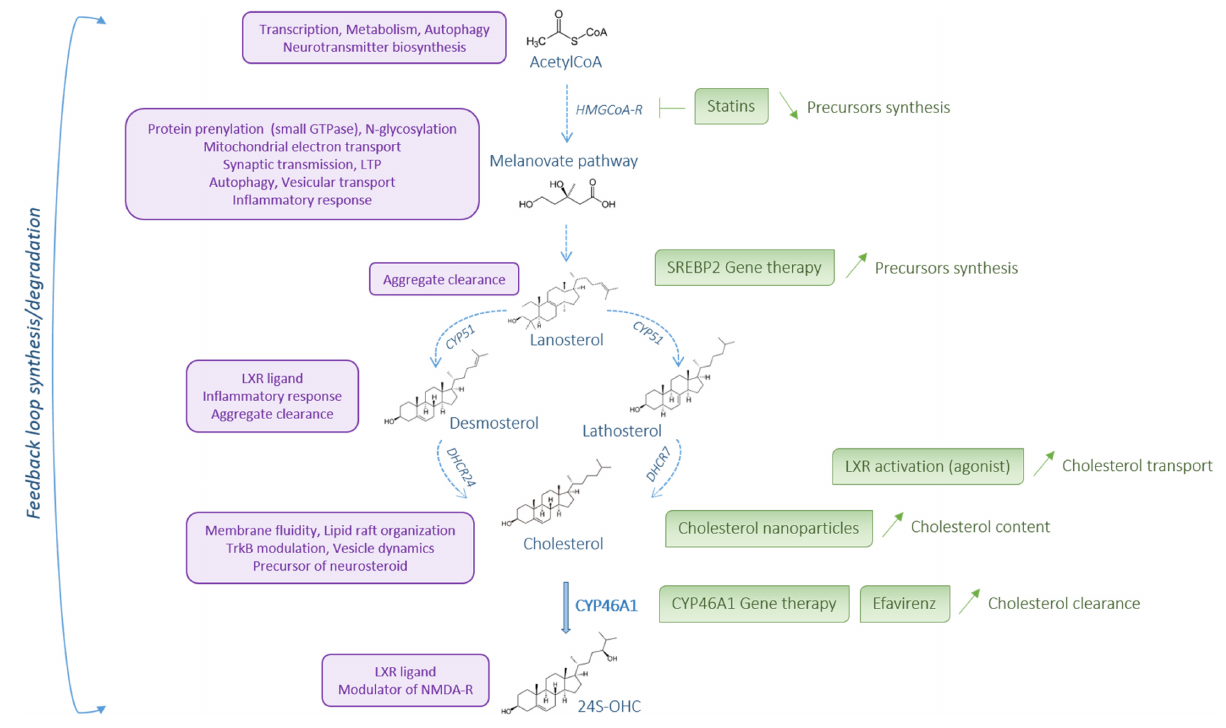
FIGURE 3 | Cholesterol metabolism: a potential therapeutic target. Cholesterol metabolism steps are represented in blue. The role and action of the different metabolites are described on the left, in purple. On the right, in green, are listed some options for therapeutical intervention to restore cholesterol metabolism in Huntington’s disease. Created with